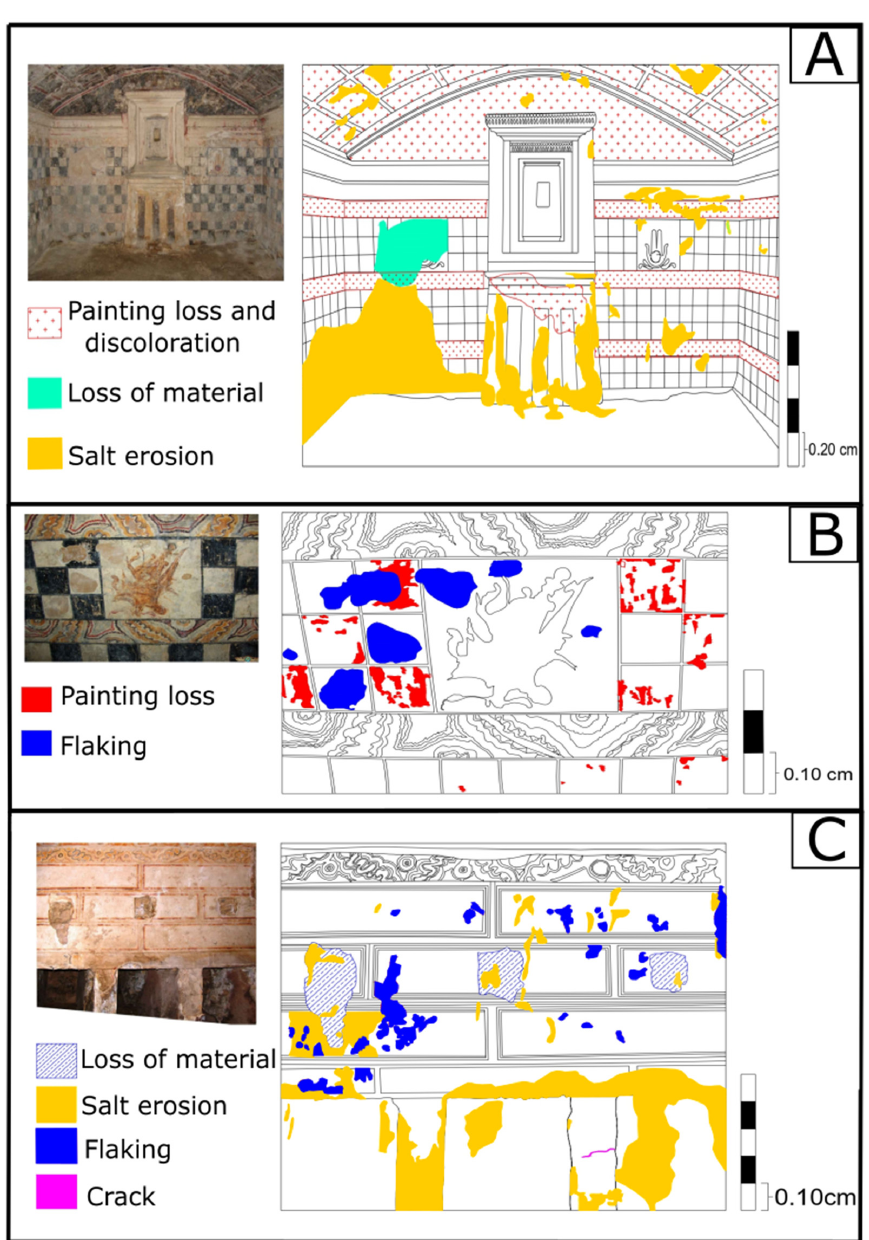
Figure 14. ( A – C ) Different decay patterns for various architectural elements of Anfushi’s Necropolis, where salt erosion is the main decay pattern on the surfaces in tomb No 2 rooms 1 and 2.